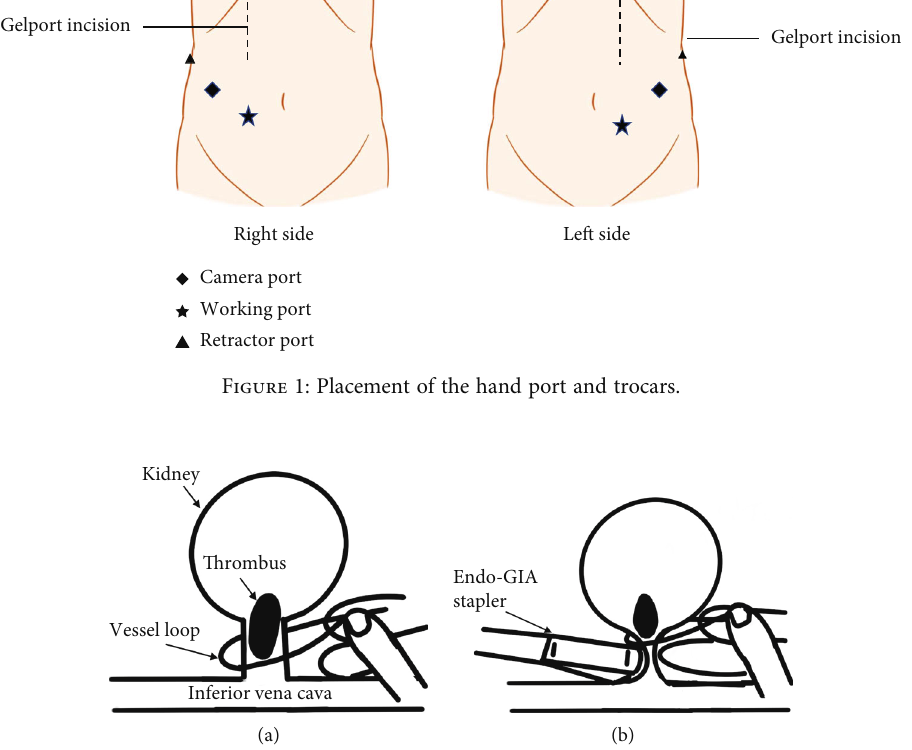
Figure 2: Schema of vascular processing in hand-assisted laparoscopic nephrectomy. (a) Thrombus tip is hooked using a vessel loop. (b) Thrombus is pulled up using the vessel loop, creating space for it to be processed using the Endo GIA